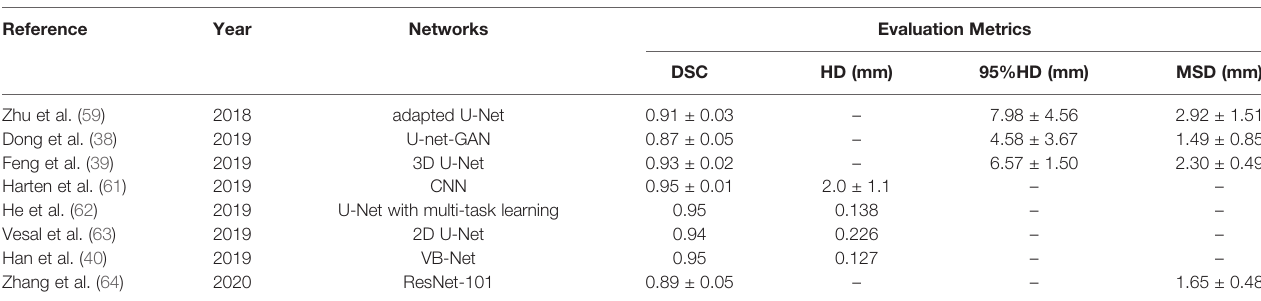
TABLE 5 | Comparison of selected works on segmentation of heart.